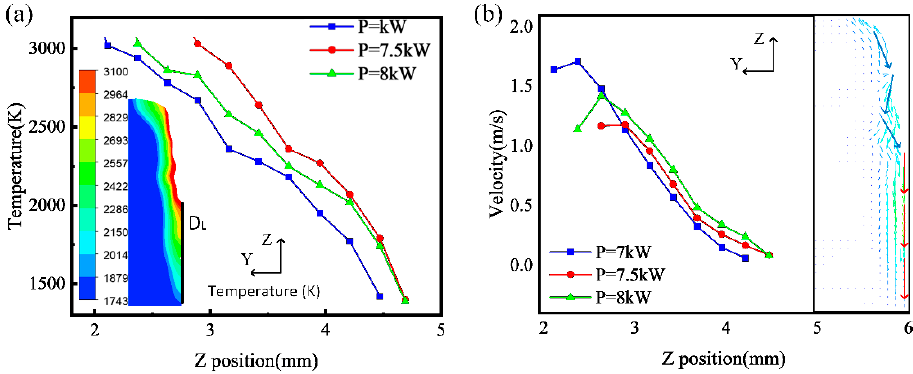
Figure 11. At simulated 35 ms: ( a ) Temperature of D L line, ( b ) speed of D L line.